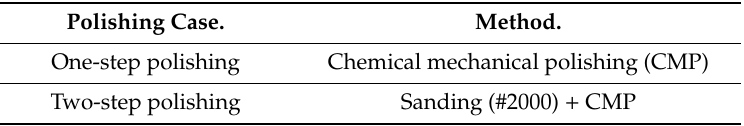
Table 1. Two cases of polishing